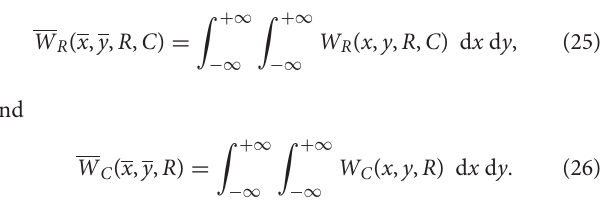
FIGURE 7 | corresponding quantitative trait mean ( y , red curve) and its expected optimum θ h , dashed red line. (B–D,F–H,J–L) show that the attack rate and handling time can evolve toward their respective optima as long as selection strength is weak in one [ τ a ( τ h ) resource abundances reaching extremely low levels. When both species experience moderate selection ( τ a (O,P,Q,U,V,W,Z,AA,BB) show that interactions avoiding collapse under weak selection are nevertheless susceptible to extinction at low abundances, curtailing the evolution of both traits. Persistent interactions are those in which joint evolution leads to a high attack rate combined with a short handling time (S,X,CC) or vice versa (T,Y,DD) . Other parameter values are: r